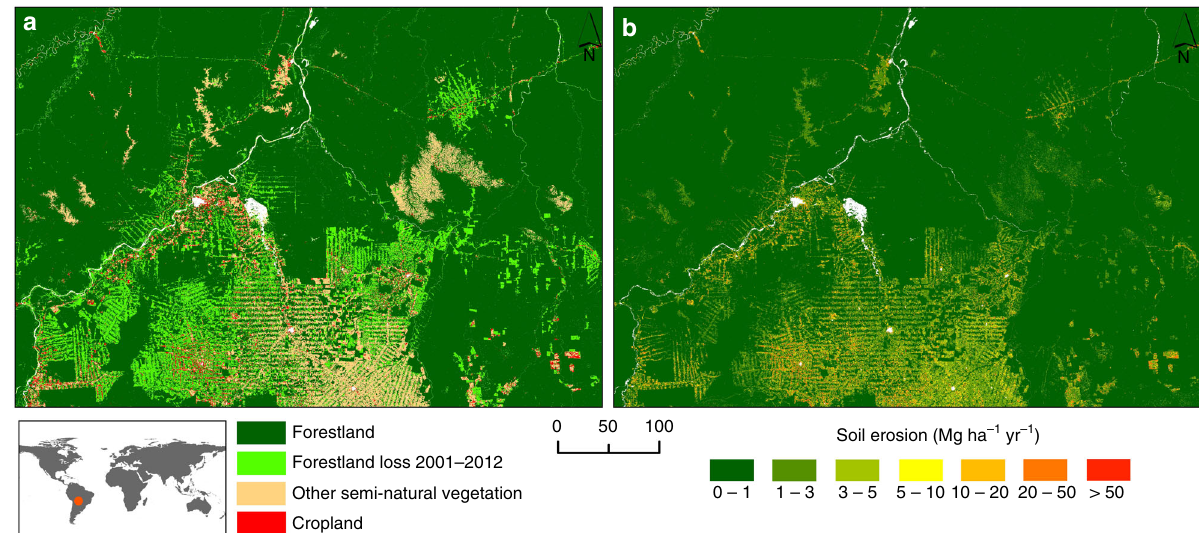
Fig. 5 Examples of the local relevance and utility of the global soil erosion estimates. a Representation of the land use/land cover data employed in this study. The area reported in the image is a region of Mato Grosso in Brasil. The light green indicates forest loss between 2001 and 2012. b Representation of the high spatial detail of the soil erosion model predictions, capable to represent the effect of the forest loss in the Mato Grosso